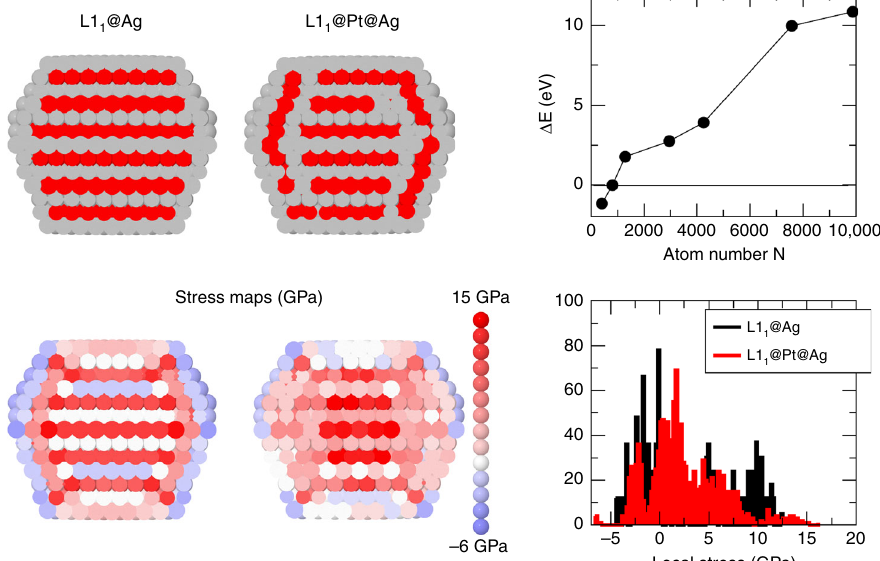
Fig. 5 Theoretical predictions of L1 1 nanophases. L1 1 @Ag core/shell and L1 1 @Pt@Ag core/subshell/shell structures for the TOh 1289 (Pt atoms in red, Ag atoms in grey) and their associated stress map in colour code from − 6 GPa for tensile stress to 15 GPa for compressive stress. The graph on the bottom right illustrates the stress distribution inside the TOh 1289 with the two structures and the graph on top shows the energy difference between the L1 1 @Ag and the L1 1 @Pt@Ag structures: positive sign means the L1 1 @Pt@Ag is the stable